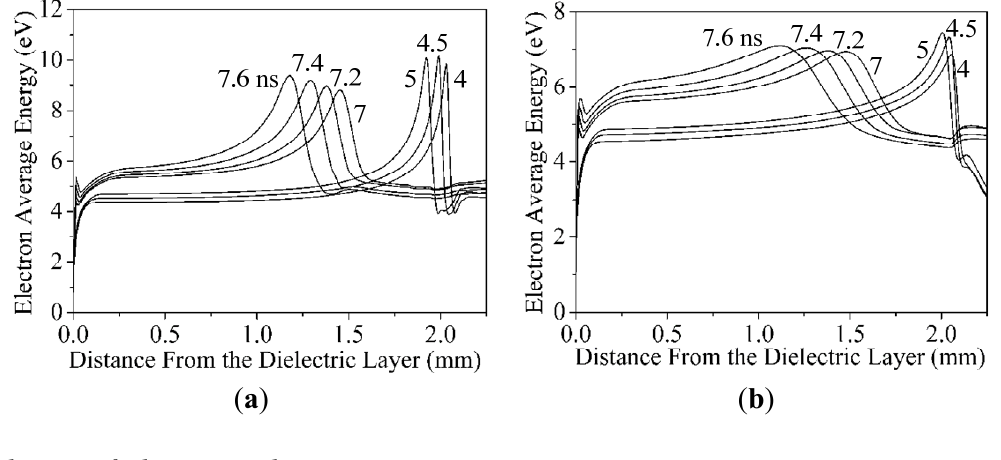
Figure 13. Electron mean energy variation along the axis of the streamer propagation of the TNG: ( a ) MN; ( b ) SN.